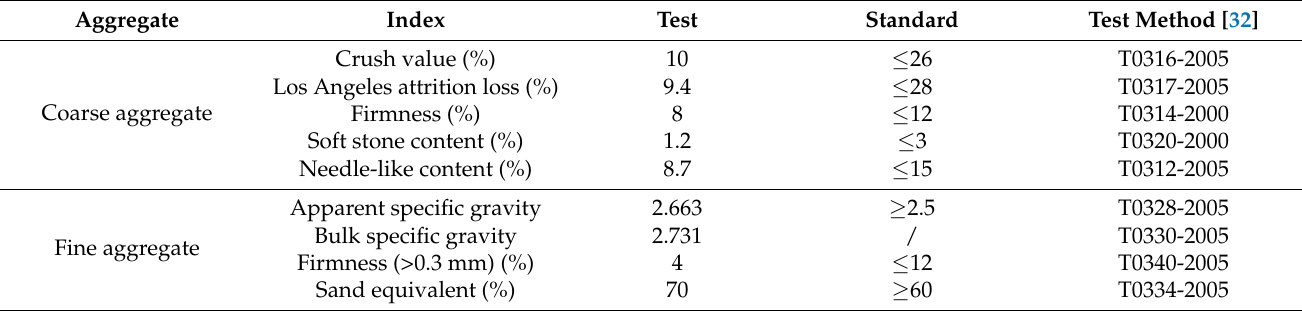
Table 2. Basic indicators of aggregates.